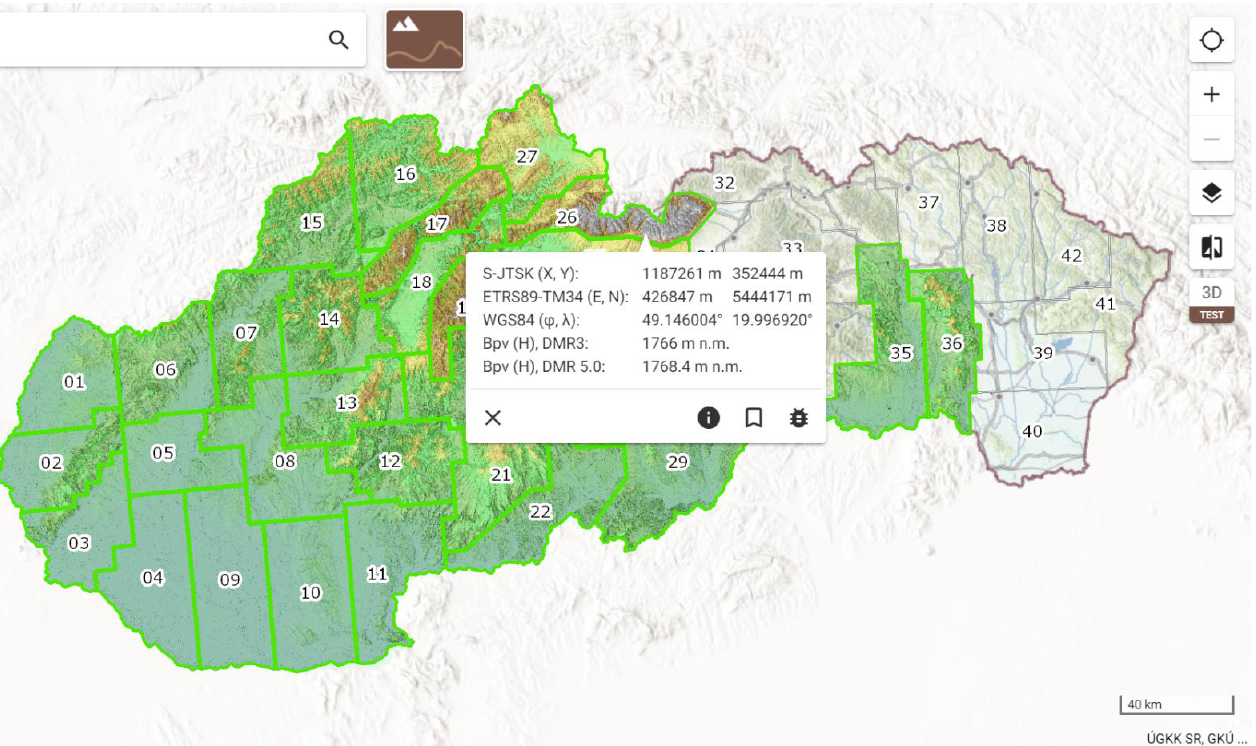
Figure 2. The ZBGIS Map Client application provided by the GCCA SR (Ú GKK SR). Areas from which DTM 5.0 data are available are highlighted in green. Source: [50].